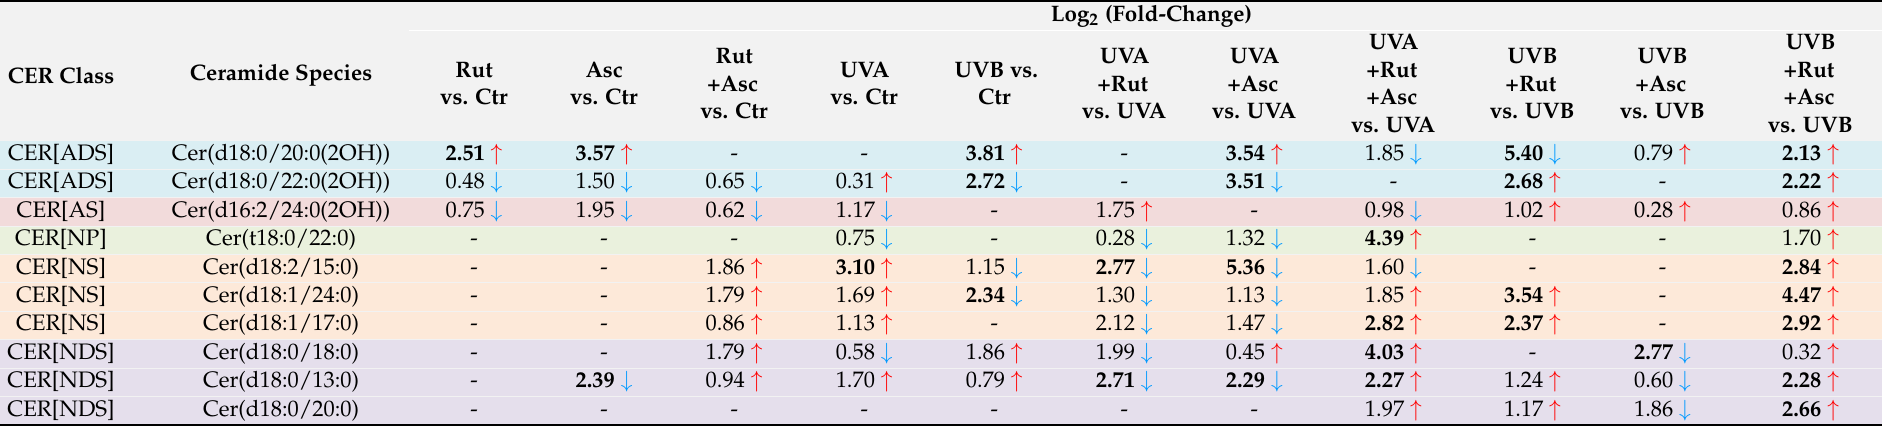
Table 2. The alteration observed in the molecular species of the 10 ceramide molecular species (selected from 25 most discriminating ceramide molecular species according to one-way ANOVA and Tukey’s post-hoc tests) in the 3D cultured fibroblasts comparing control (Ctr) with rutin (Rut (25 µ M)), control with ascorbic acid (Asc (100 µ M)), control with Rut+Asc, UVA with Rut, UVA with UVA+Asc, UVA with UVA+Rut+Asc, UVB with Rut, UVB with UVB+Asc, and UVB with UVB+Rut+Asc, along with their respective fold change. All the alterations are significant at the p < 0.05 level. Abbreviations: non-hydroxy fatty acid [N], α -hydroxy fatty acid [A], and esterified ω -hydroxy fatty acid [EO], dihydrosphingosine [DS], sphingosine [S], and phytosphingosine [P]. The bold indicates high fold change (more than 2-fold); red arrows indicate the increased level; blue arrows indicate the decreased level; -, not significant changes. The table with the 25 most discriminating ceramide molecular species is included in Supplementary Materials (Supplementary Table